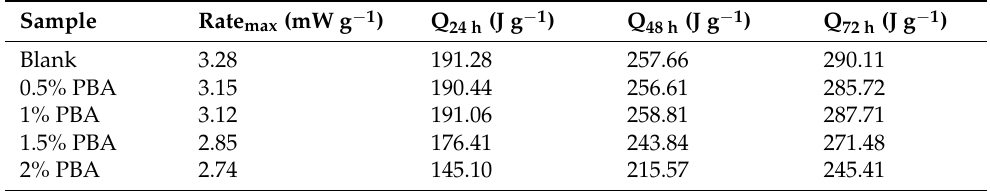
Table 4. Changes in the maximum hydration rate and heat of hydration of cement pastes with different dosages of PBA.